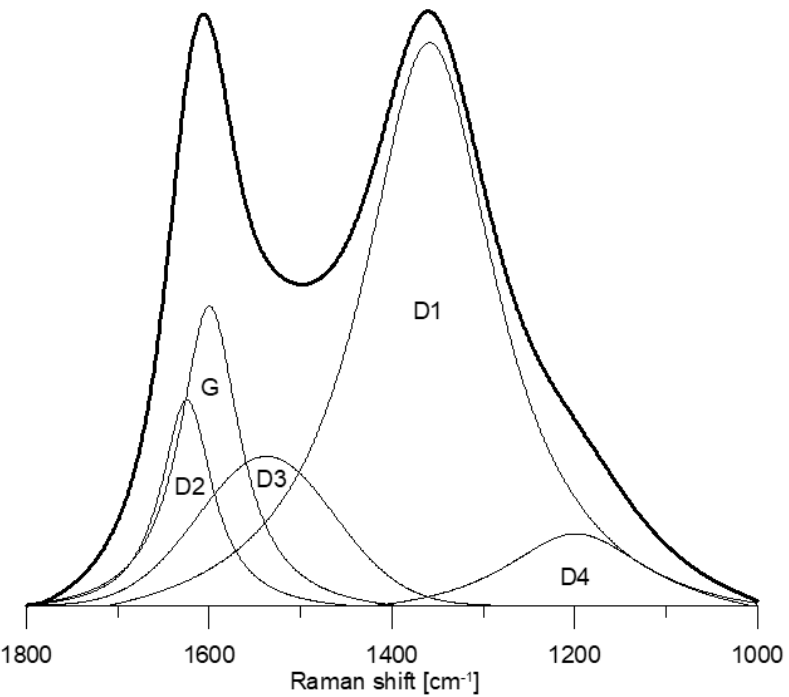
Figure 3. Curve-fitting of a representative inertoid spectrum.